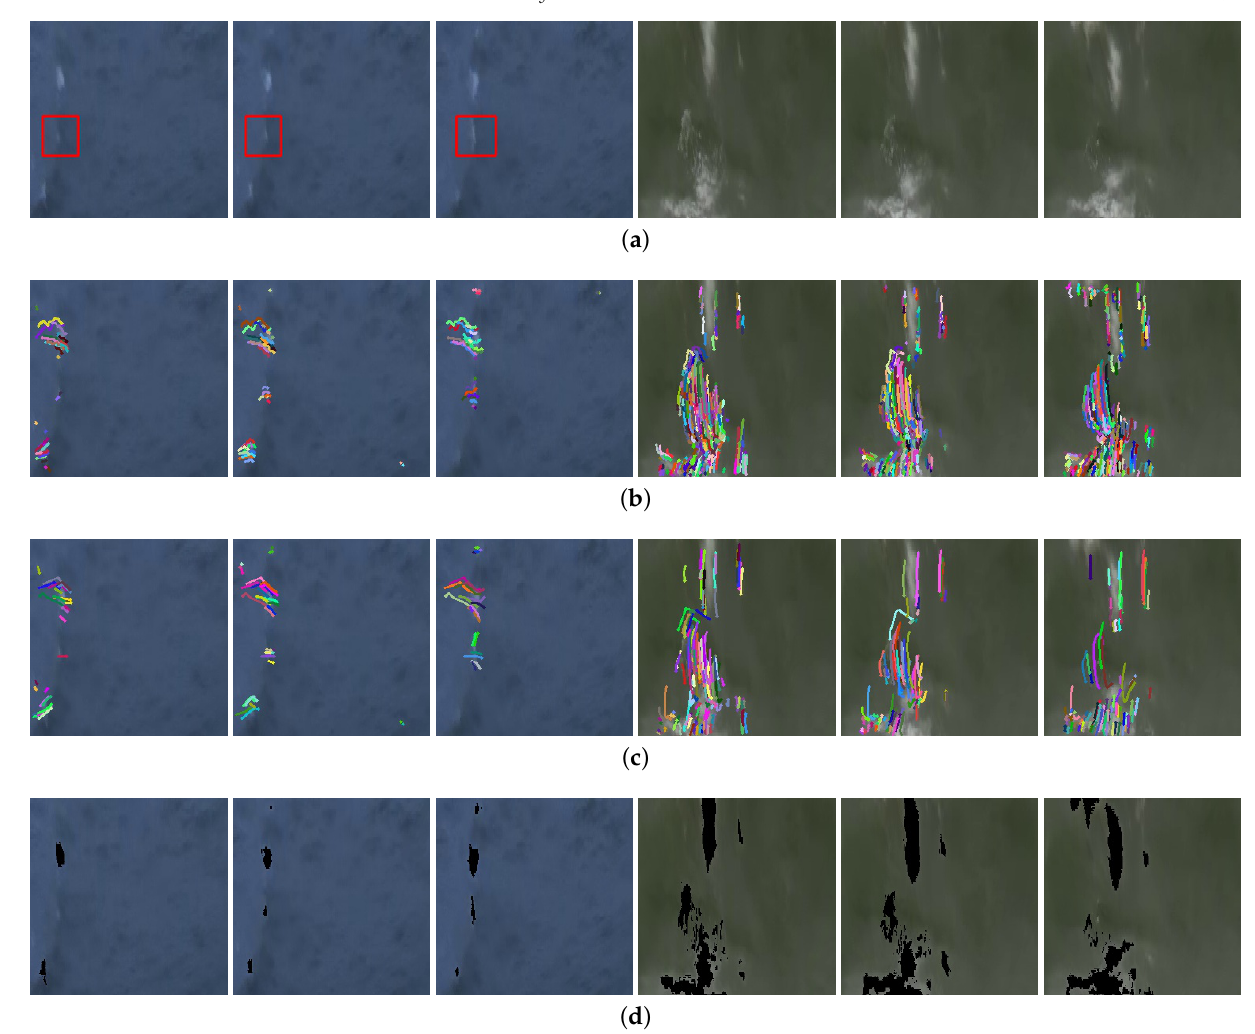
Figure 10. ( a ) Original images where the interval ∆ t between two images is 0.16 s; ( b ) T h at f h = 25 Hz. Within ∆ t , the trajectories were updated 4 times; ( c ) T l at f l = 6.25 Hz. Within ∆ t , the trajectories were only updated 1 time; and ( d ) whitecap retrieval result using our method under no sun glint conditions. Whitecap areas are shown as black